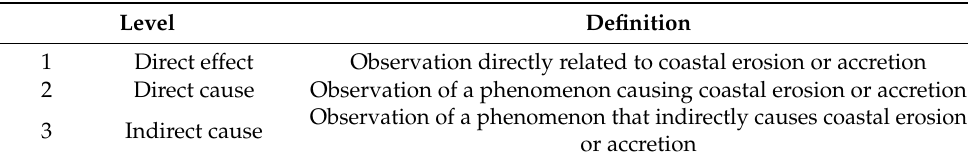
Table 4. Cause–effect scale for the prioritization of CDM effects at the subtype